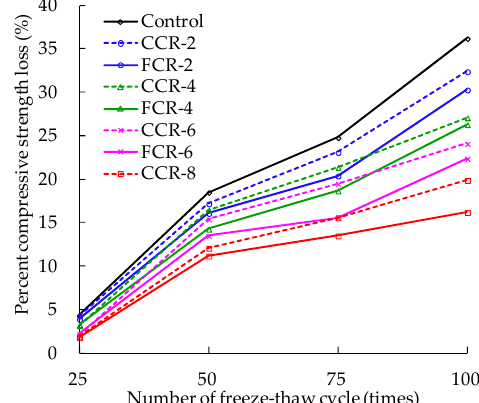
Figure 11. Compressive strength loss ratio of control pervious concrete (CPC) and RMPC under freeze–thaw cycles.